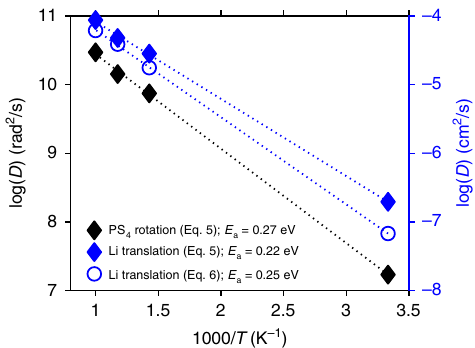
Fig. 6 Calculated Arrhenius plots and activation energies for anion rotational diffusion and Li translational diffusion in 75Li 2 S – 25P 2 S 5 glass. Data from the Green – Kubo formula (Eq. 5) are shown with diamonds; data from the Einstein formula (Eq. 6) appear as open blue circles. The dotted lines are a linear fi t to the data at 1000, 850, and 700 K. Values at 300 K are extrapolated from the high-temperature